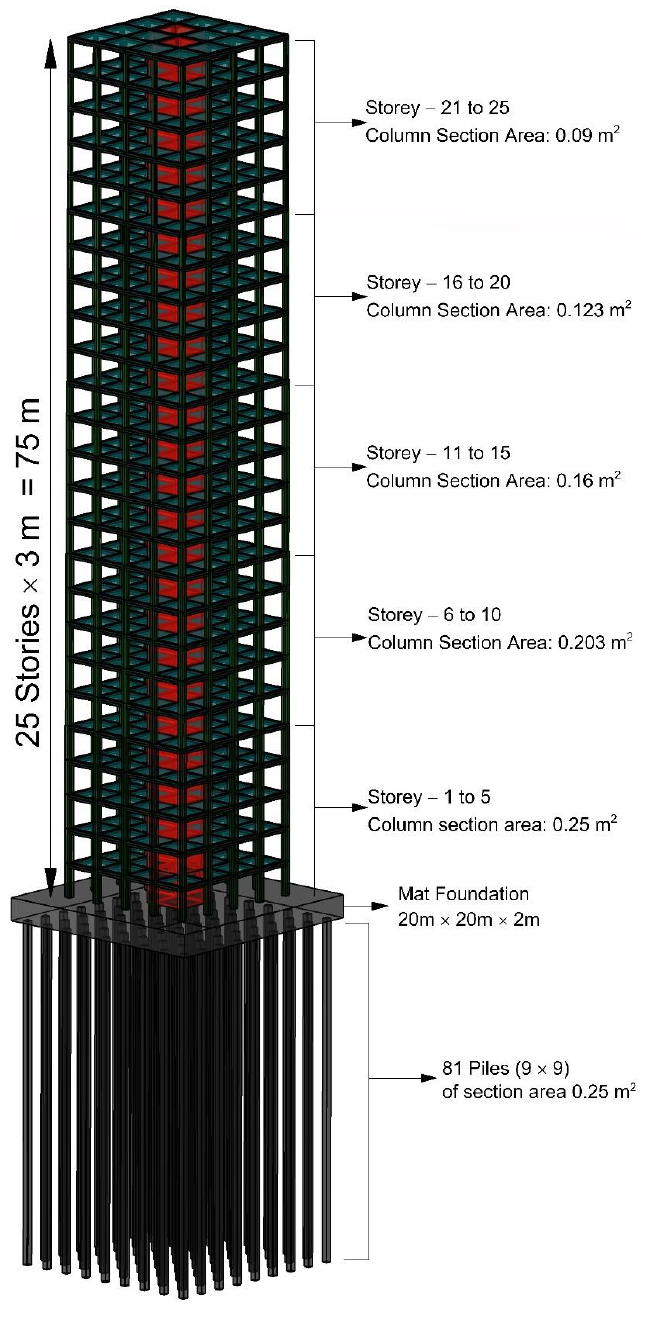
Figure 3. Details of the designed structural sections of the 25-story building used for the analysis. Table 1. Details of the designed sections used in the study.